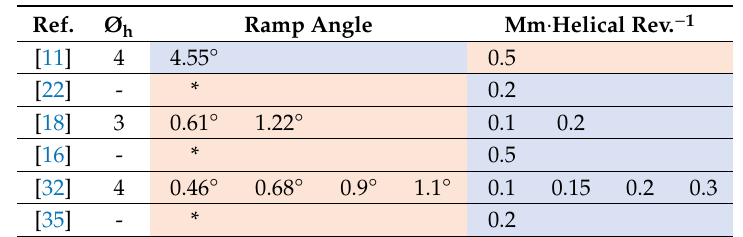
Table 4. Values provided in the publication consulted for axial movement in ramp angle and millimetre per helical revolution.